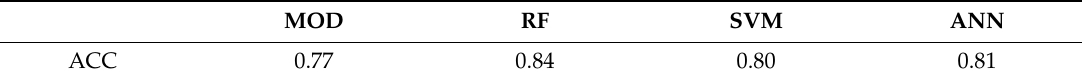
Table 4. Overall average accuracy (ACC) of MOD10A1 (MOD), random forest (RF), support vector machine (SVM) and back-propagation artificial neural network (ANN) over the Tibetan Plateau.